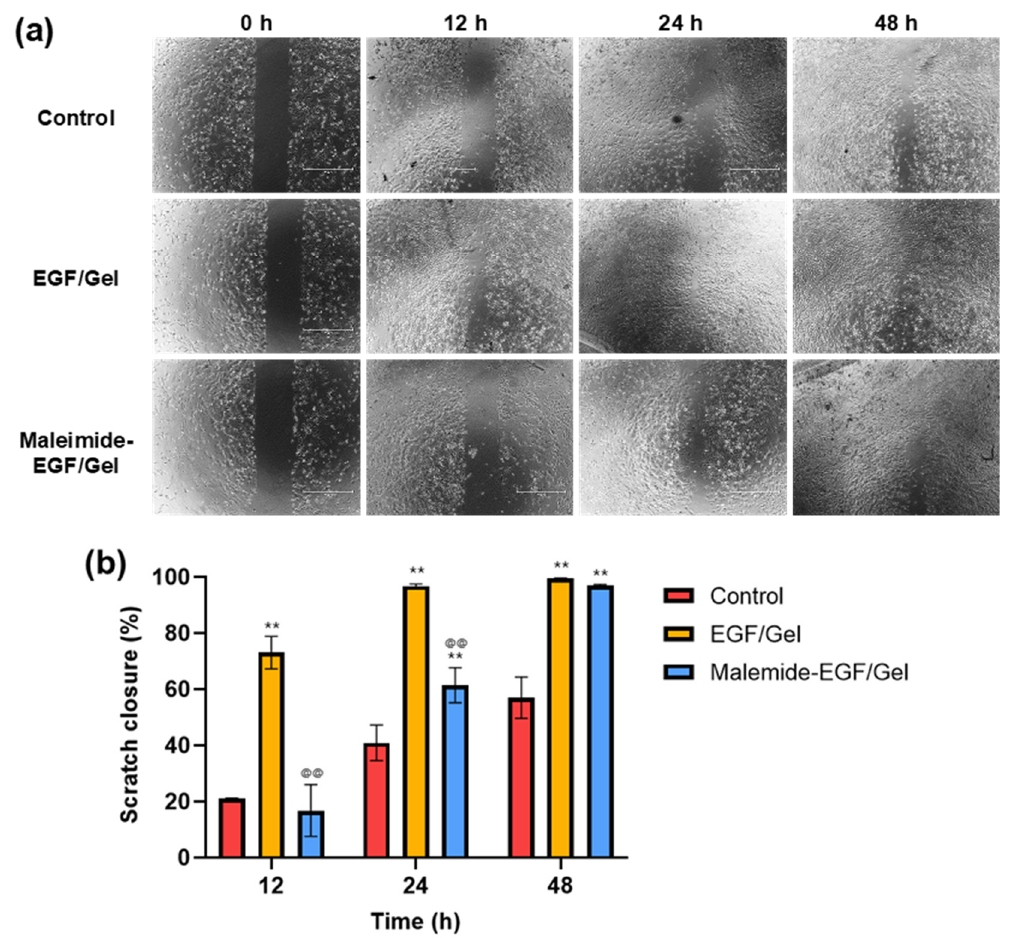
Figure 9. Scratch assay of fibroblasts for EGF and maleimide-EGF as a function of treatment conditions. ( a ) Representative images taken at 0, 12, 24, and 48 h after applying EGFs. ( b ) Quantification of scratch closure using the wound-healing measurement tool of ImageJ. The scratch closure was evaluated by dividing the open area by initial scratch area. The symbols * and @ are used to represent significant differences when compared with the control and EGF/Gel groups, respectively. The significant differences are represented by 0.01 < p < 0.05 (* and @) and p < 0.01 (** and @@).